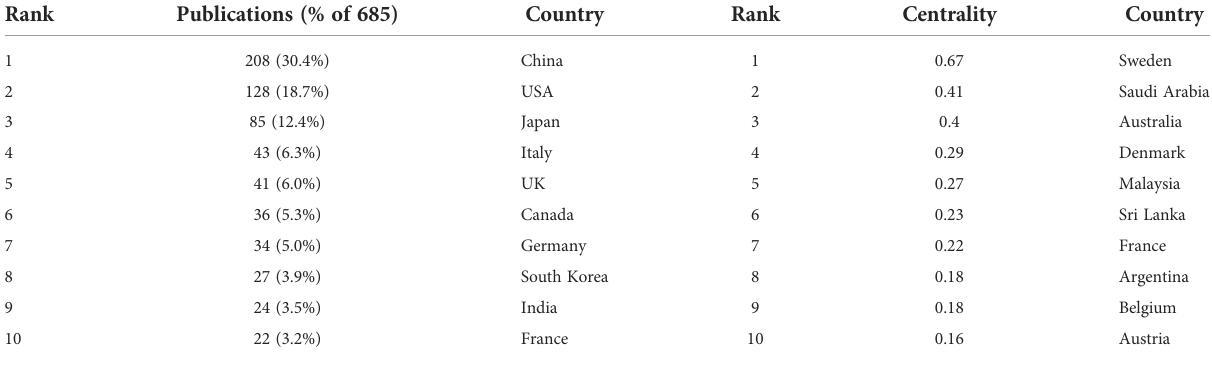
TABLE 2 Top 10 countries in terms of publications and centrality. Rank Publications (% of 685) Country Rank Centrality